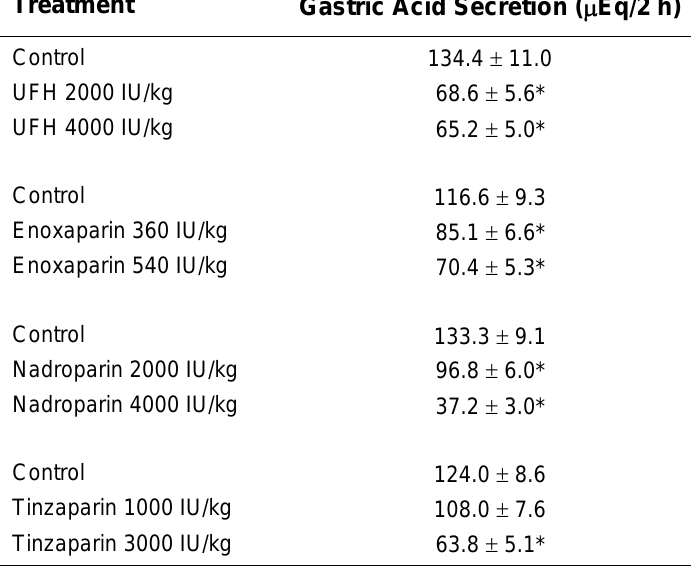
The control group was treated with vehicle (saline). * p < 0.05 vs. corresponding control group. One-way ANOVA and Duncan’s multiple range comparison test. n =